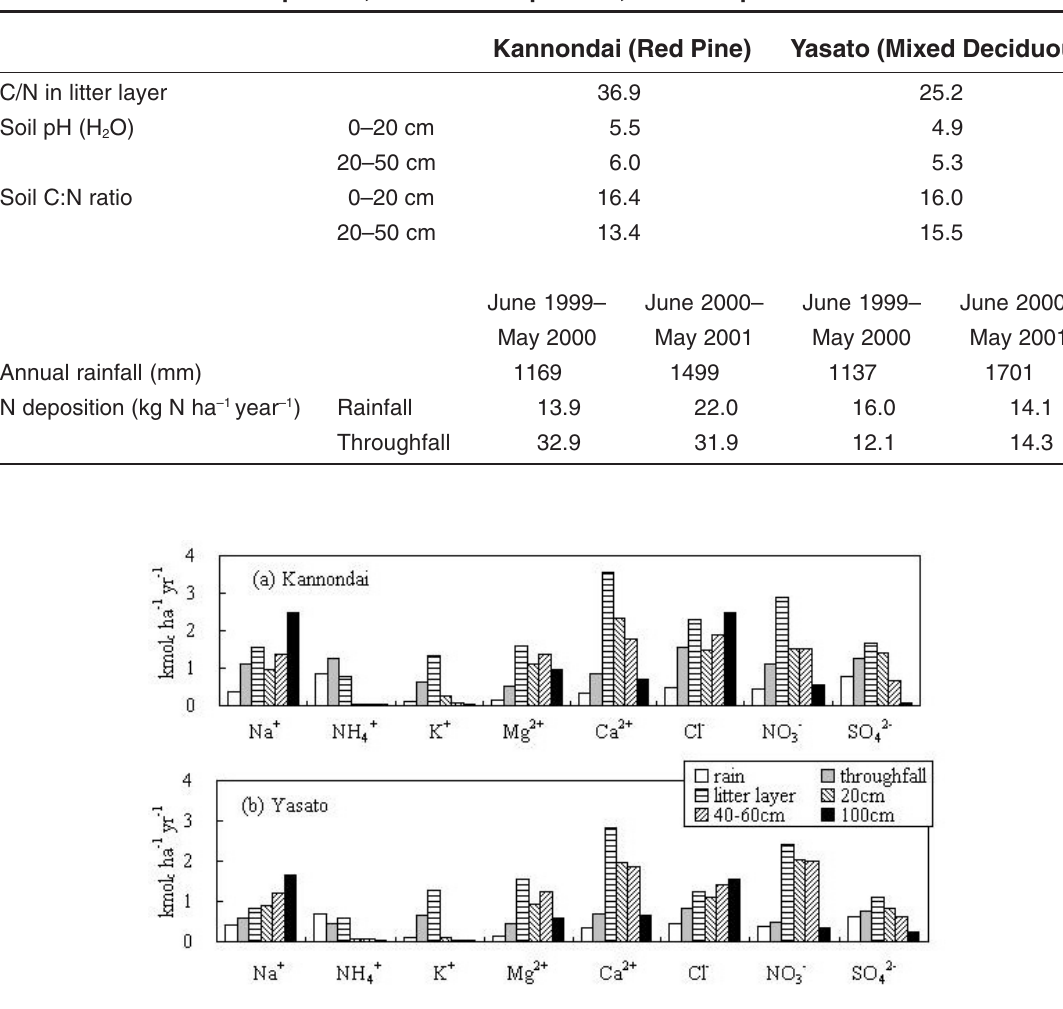
FIGURE 2 . Yearly fluxes of ionic constituents in the area without nitrogen manipulation (June 1999 to May